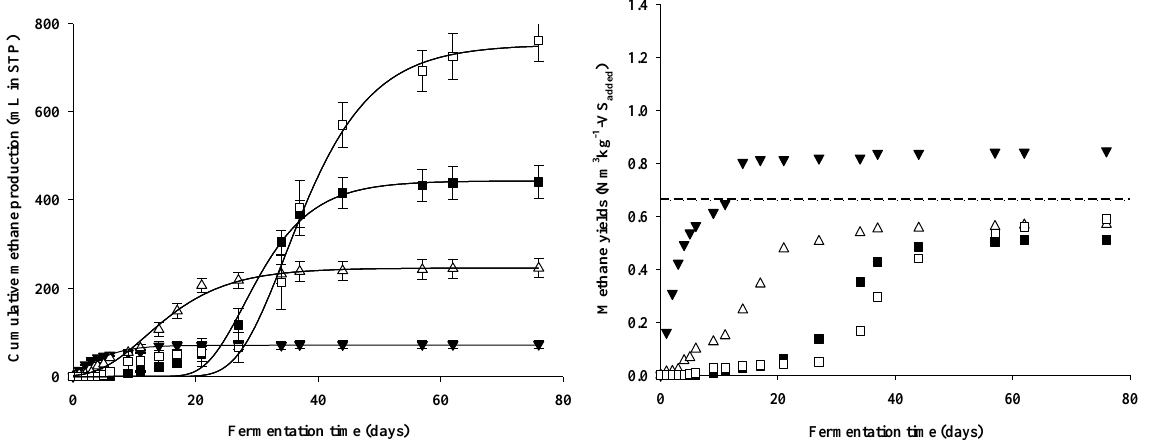
Figure 2. Cumulative methane production and yield for intestine residue during batch anaerobic digestion at different S/I ratios. ▼,  , ■, and □ indicate substrate to inoculum (S/I) ratios of 0.10, 0.50, 1.00, and 1.50, respectively, and --- is B th (0.664 Nm 3 /kg-VS added ). Vertical bars indicate standard deviations.